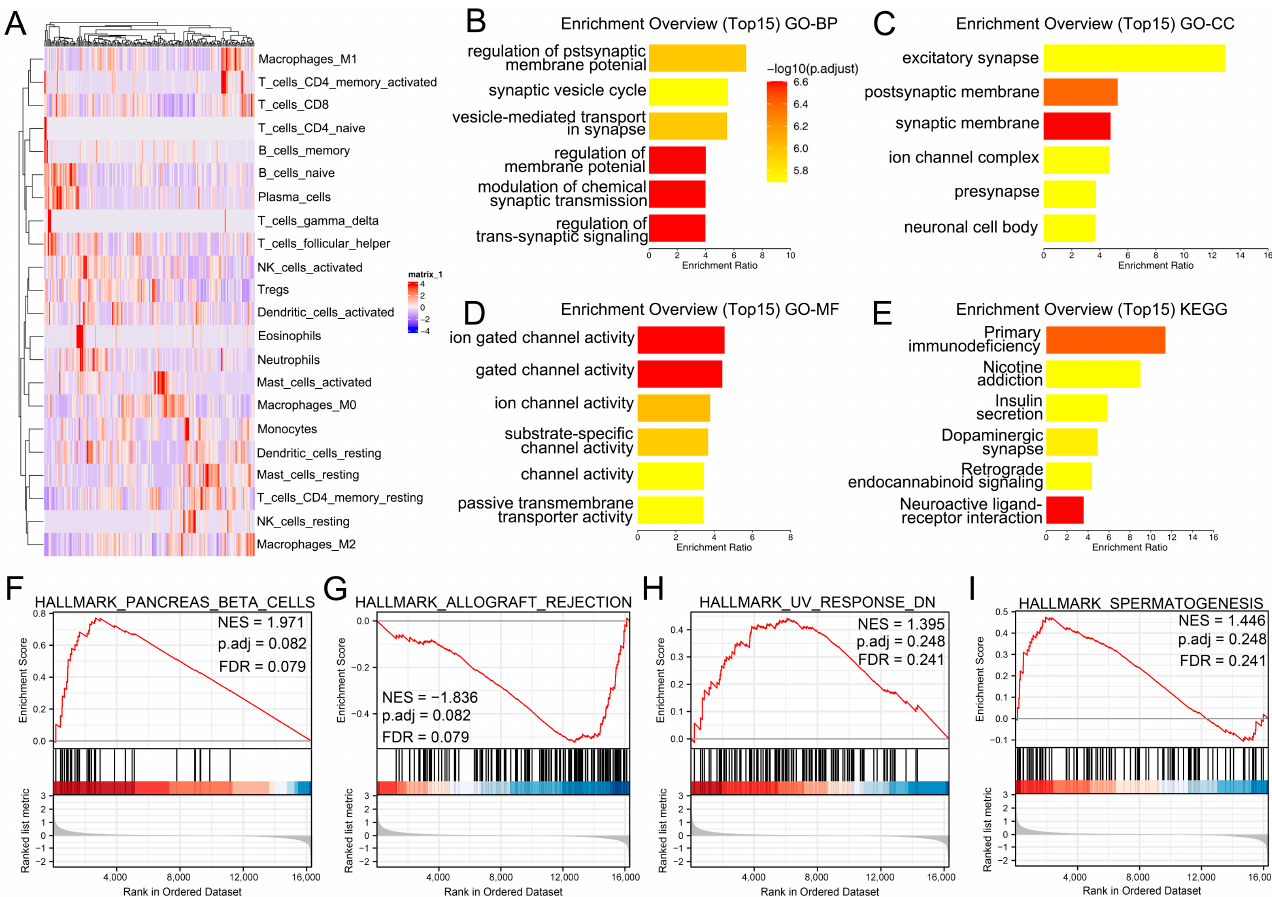
Figure 2. Role of M2 macrophages in PC. Notes: ( A ) CIBERSORT algorithm was used to quantify the PC microenvironment; ( B ) GO-BP analysis of M2 macrophages; ( C ) GO-CC analysis of M2 macrophages; ( D ) GO-MF analysis of M2 macrophages; ( E ) KEGG analysis of M2 macrophages; ( F – I ) Hallmark analysis of the M2 macrophages (the red color under the black line represents the gene has a promoting e ff ect on the activity of this pathway, while blue color has the opposite e ff ect).